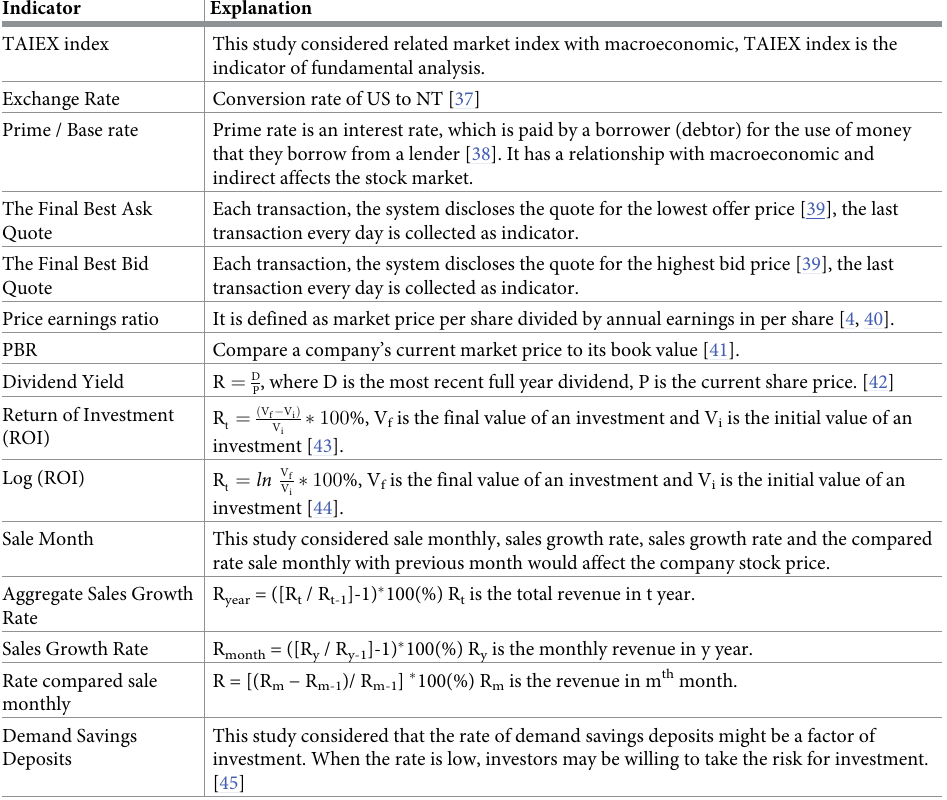
Table 2. Fundamental